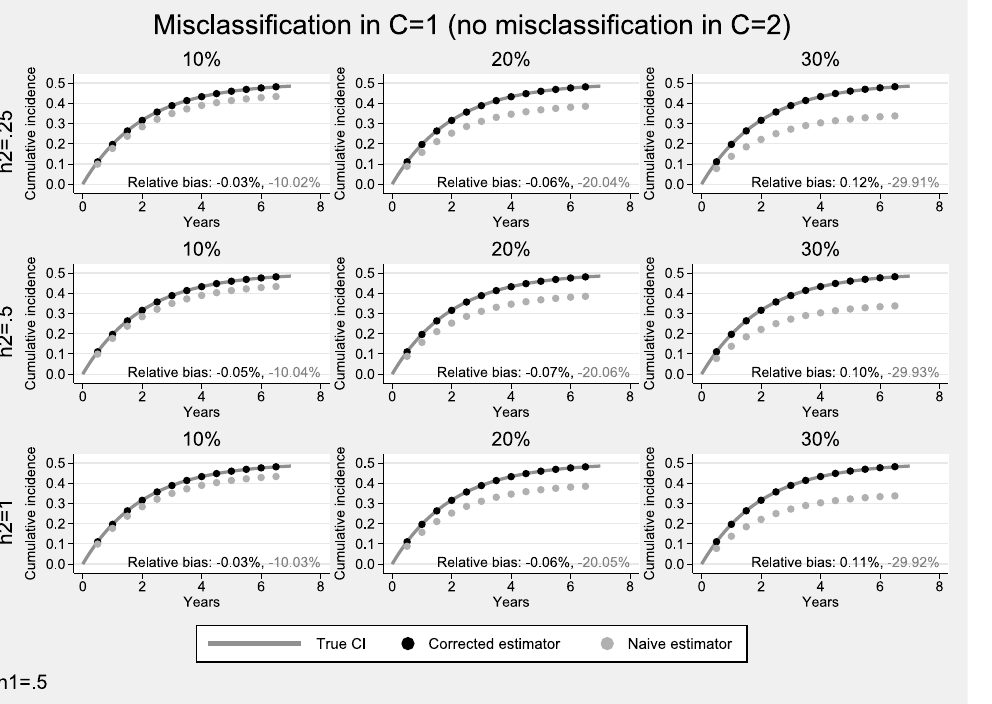
Fig 2. Simulation results for the case of unidirectional misclassification: Only the primary endpoint was subjected to misclassification. The hazard for the primary endpoint was assumed to be moderate ( h 1 = 0.5). Solid lines correspond to the true cumulative incidence whereas dotted lines to the estimates from the non-parametric Aalen-Johansen estimator for the primary